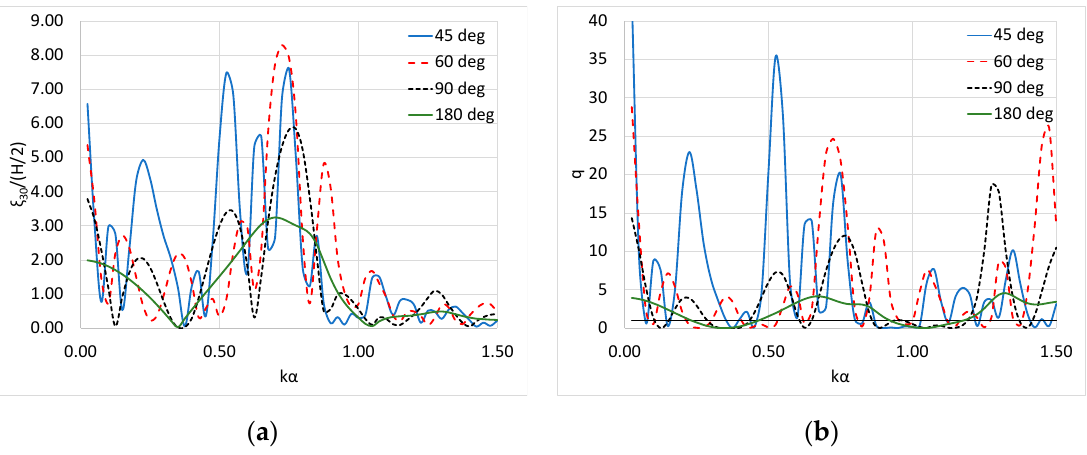
Figure 7. Effect of the V-shaped breakwater on the WEC’s (wave energy converter) performance for various examined formed breakwater angles θ : ( a ) WEC’s (wave energy converter) heave motions; ( b ) q factor term. The horizontal solid line corresponds to unity.